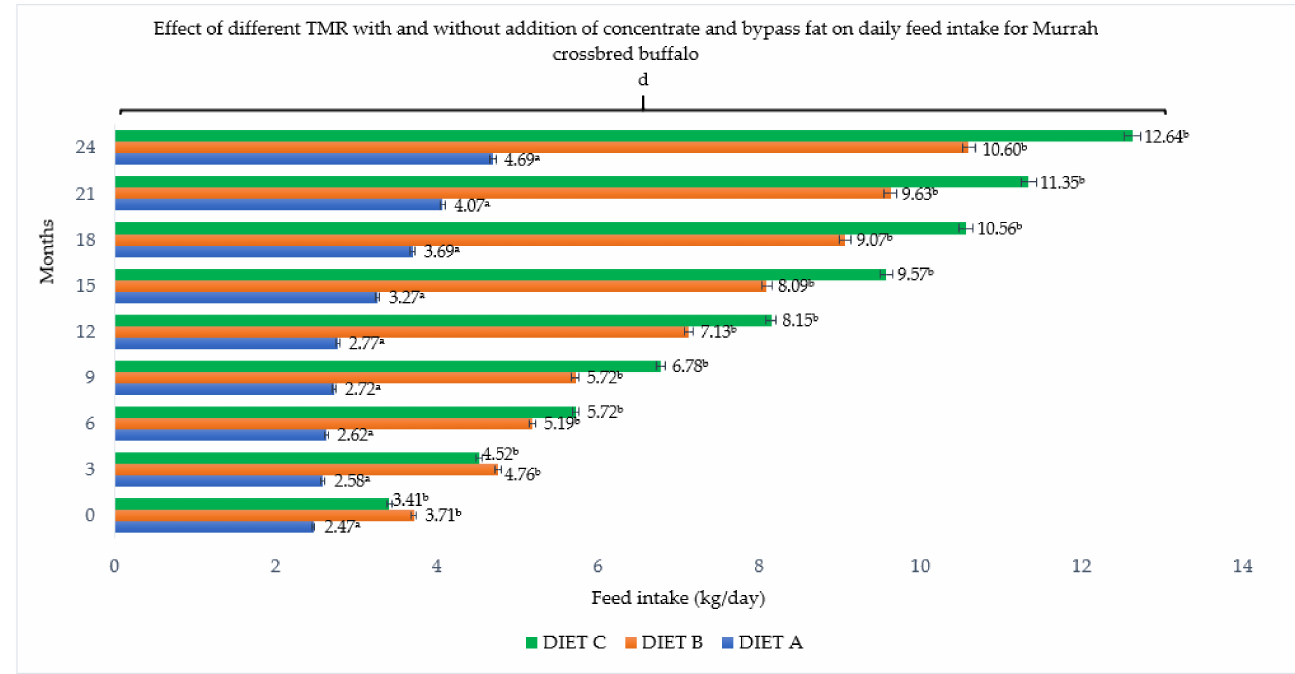
Figure 1. Effect of different TMR with and without addition of concentrate and bypass fat on daily feed intake for Murrah cross buffalo. Diet A (control)—(100% Brachiaria decumbens) ; Diet B—(70% Brachiaria decumbens + 30% concentrate); Diet C—(70% Brachiaria decumbens + 26% concentrate + 4% bypass fat); the values are presented as mean; a,b different superscripts indicate significant difference on daily feed intake for Murrah crossbred buffalo at p < 0.05; d indicating significant ( p < 0.05) difference comparing between months and feed intake.